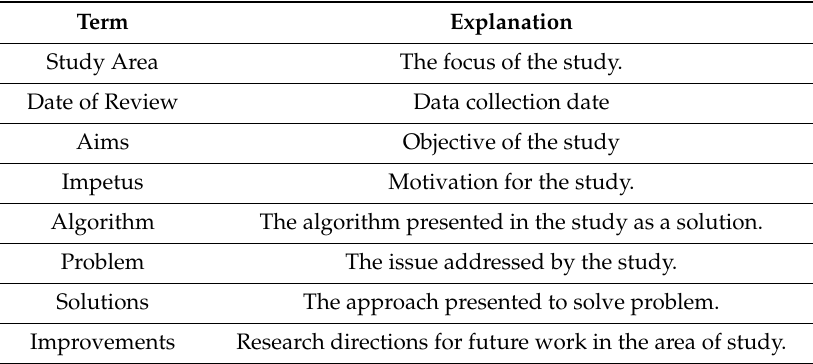
Table 4. Terminology for data collection.